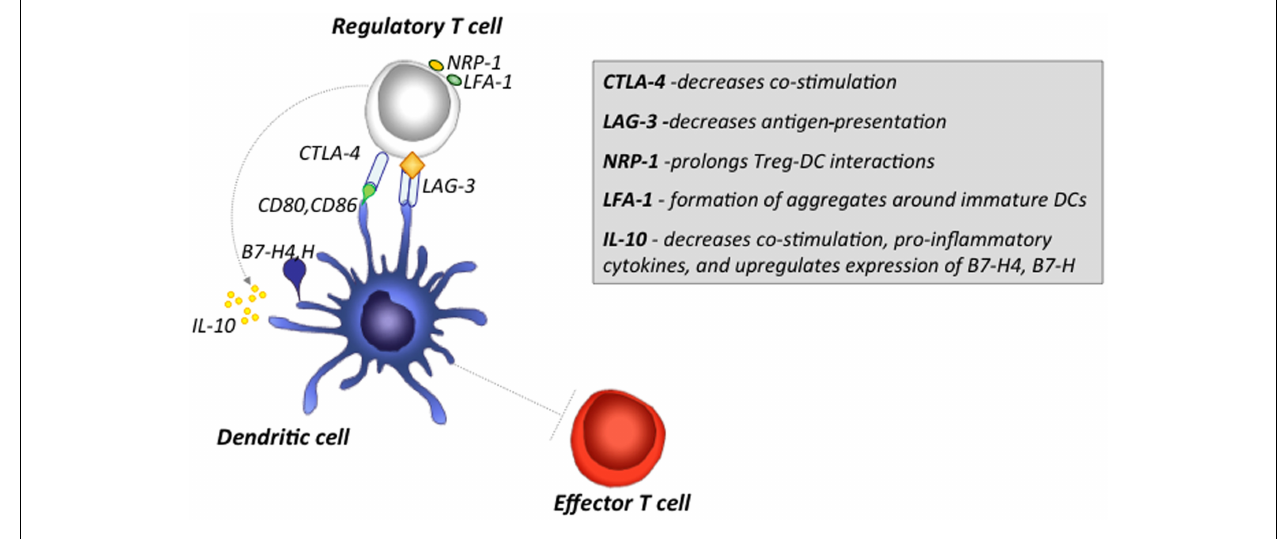
FIGURE 1 | Major mechanisms by whichT reg cells induce tolerogenic DCs and inhibitT eff cell activation. T reg cells can inhibit the function of DCs through various mechanisms. CTLA-4 expression onT reg cells down-regulates up-regulation of CD80 and CD86 co-stimulatory molecules on DCs. LAG3 binding to MHCII-expressing immature DCs results in inhibitory signals that suppress DCs maturation and co-stimulatory capacity. Nrp-1 expression onT reg cells promotes sustained interactions between